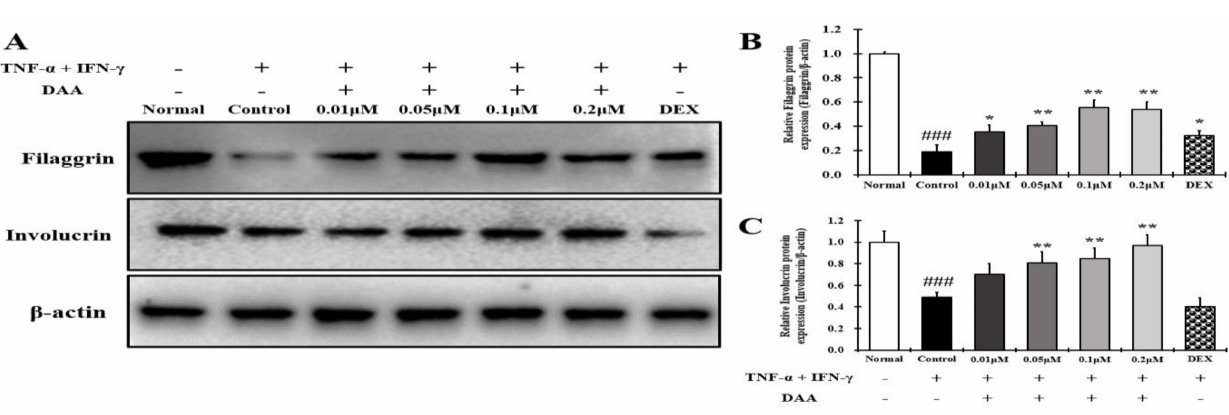
Figure 9. Effect of DAA on MAPK phosphorylation and NF- κ B activation in HaCaT cells. ( A ) DAA inhibited the phosphorylation of MAPK (ERK, JNK, and P38) in HaCaT cells ( A-a – A-c ). ( B ) DAA also inhibited the degradation of IkB α and the translocation of NF-kB to the nucleus ( B-a , B-b ). I κ B α was normalized to β -actin and NF-kB was normalized to Lamin B1. The results are expressed as the mean ± SD (n = 4). ### p < 0.001 vs. normal; * p < 0.05, *** p < 0.001 vs. control. DAA was used at 0.01 µ M, 0.05 µ M, 0.1 µ M, and 0.2 µ M. DEX, the positive control, was used at 0.1 µ M.